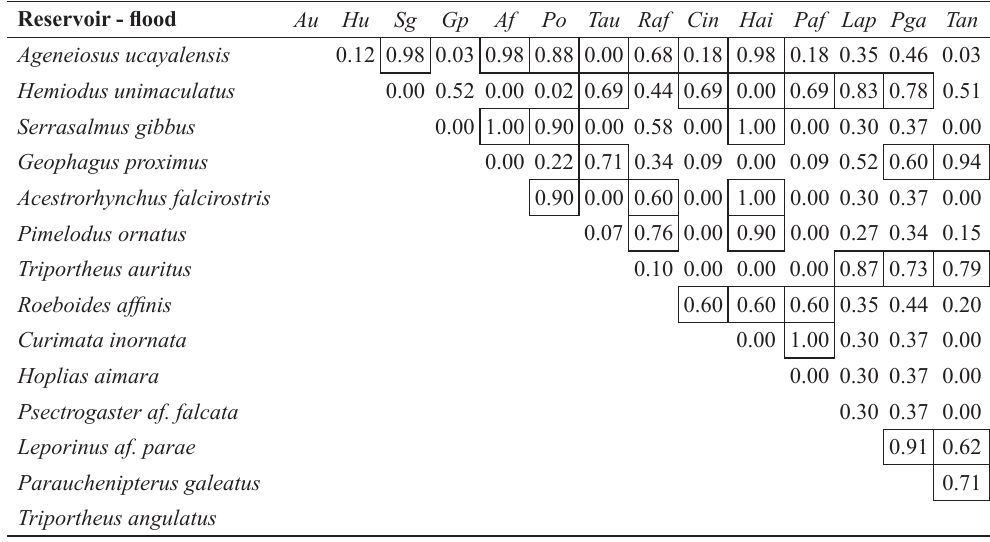
Niche overlap between pairs of species analyzed from Reservoir area of Coaracy Nunes Dam, Ferreira Gomes – Amapá